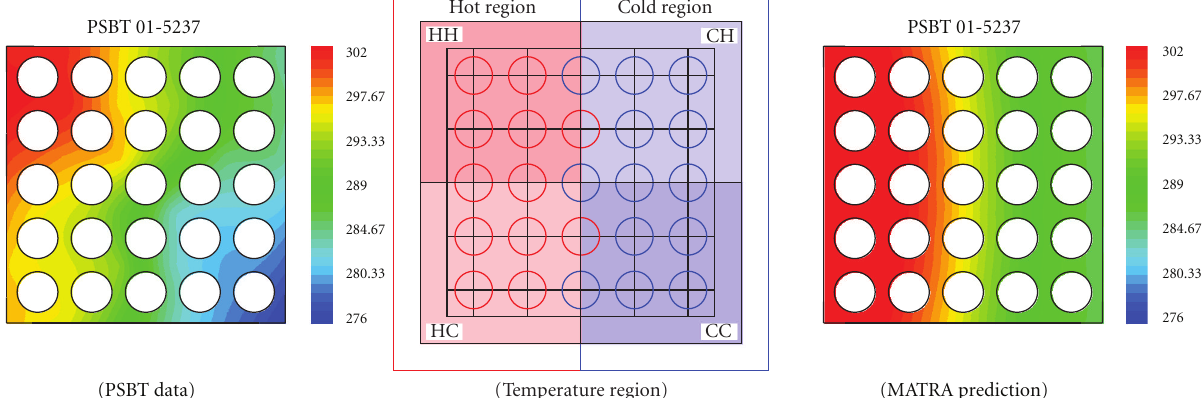
Figure 6: Comparison of fluid temperature distribution in a 5 × 5 test